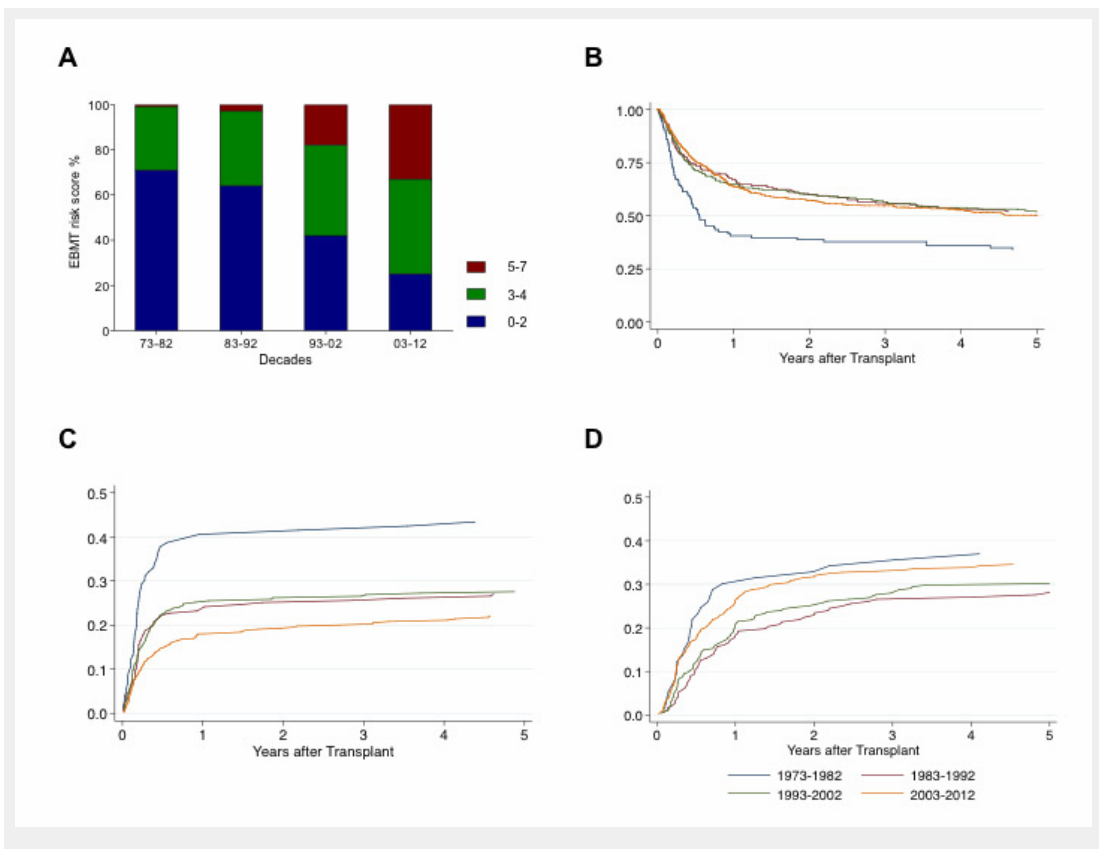
Figure 3 (A) European Group for Blood and Marrow Transplantation (EBMT) risk score distribution in % over the decades for allogeneic haematopoietic stem cell transplantation (HSCT). (B) Overall survival after allogeneic HSCT. (C) treatment-related mortality after allogeneic HSCT. (D) relapse incidence after allogeneic HSCT. EBMT risk score: 0–2 (blue) = low; 3–4 (green) = intermediate, 5–7 (red) = high pretransplant risk constellation